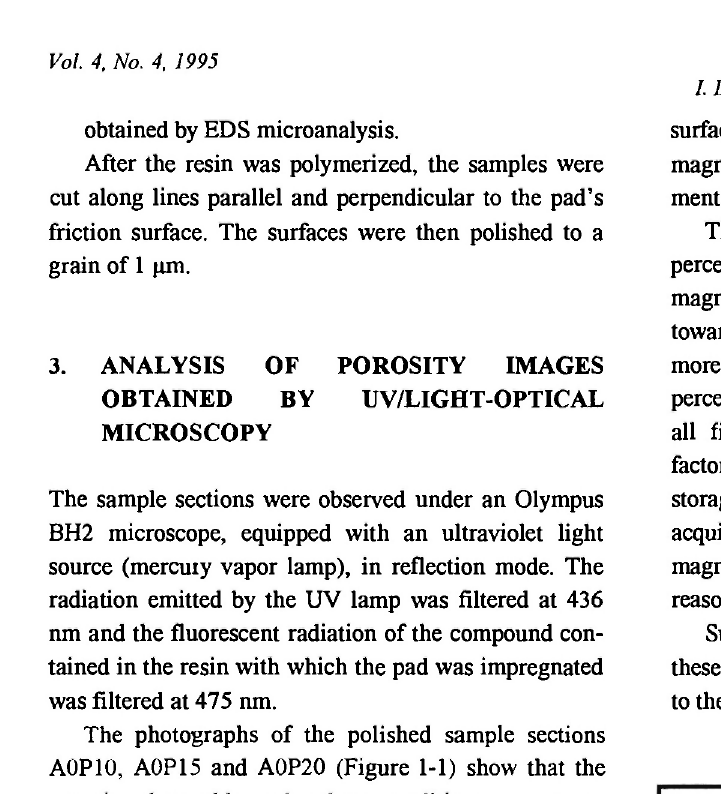
Table of surface area percentages in the planes parallel or perpendicular to the friction surface as a function of target